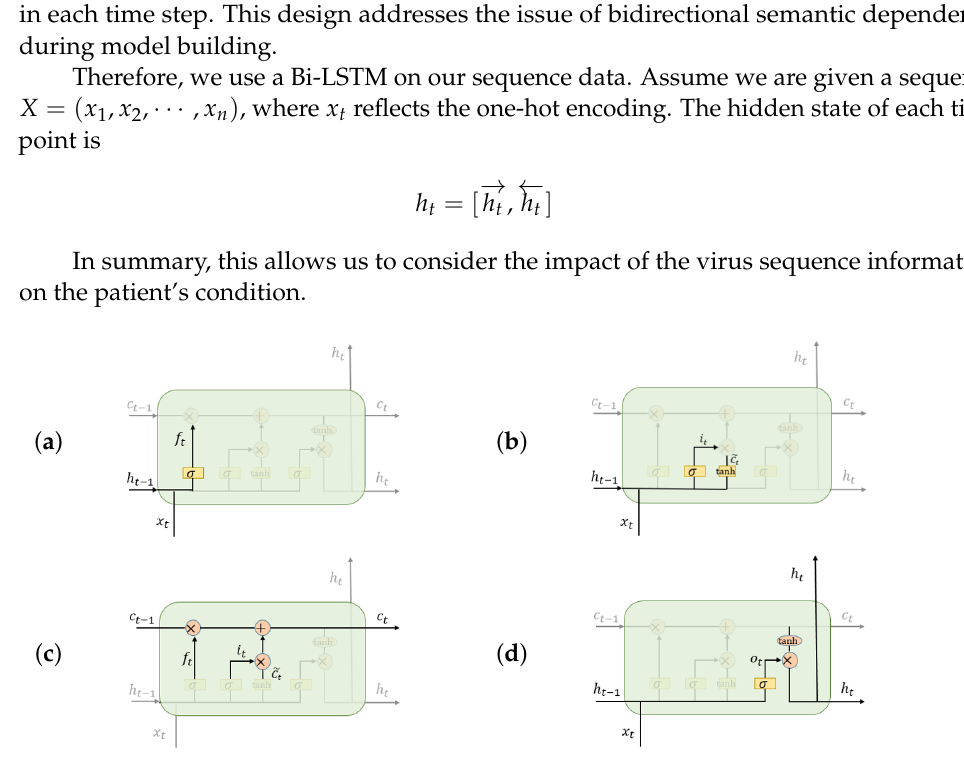
Figure 4. Operation of gates in an LSTM cell. The LSTM determines the hidden state and cell state at the present sequence location as follows. ( a ) A forget gate f t controls the input of the ( t − 1)th hidden state, ( b ) an input gate i t controls the input of x t , ( c ) a transitional phase calculates the t th positions cell state, and then, finally, ( d ) an output gate O t returns the t th position’s hidden state h t